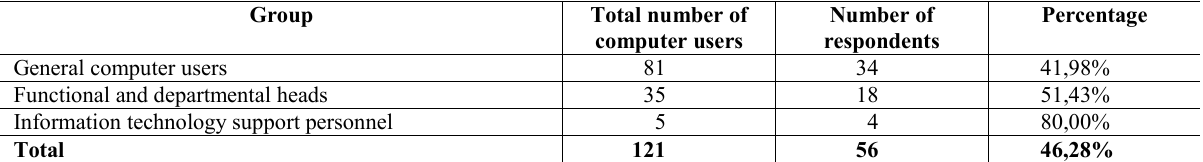
Table 1: Response rate